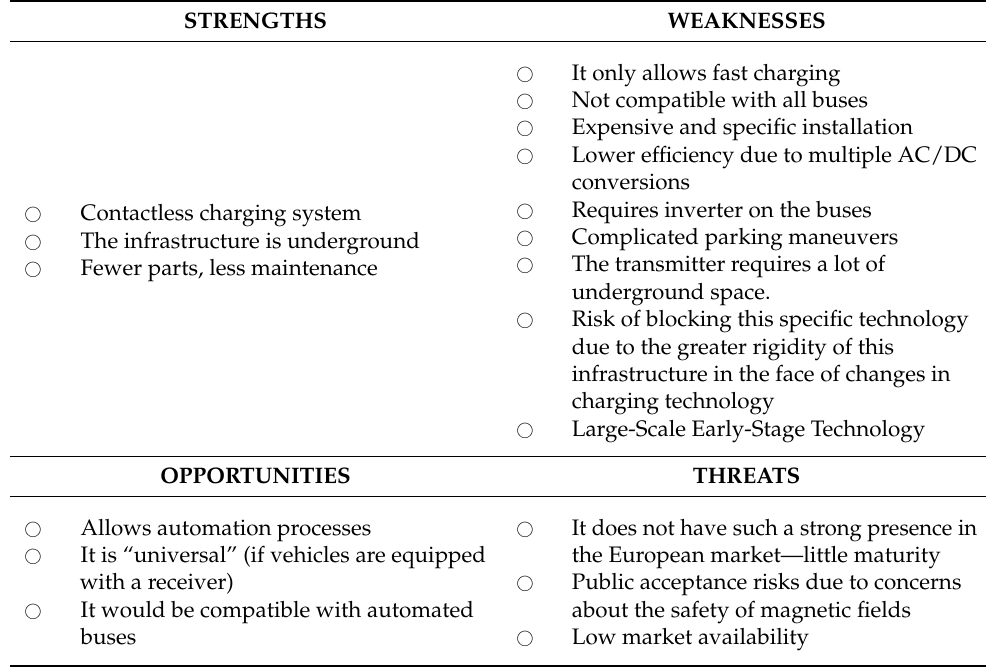
Table 4. SWOT analysis of Inductive